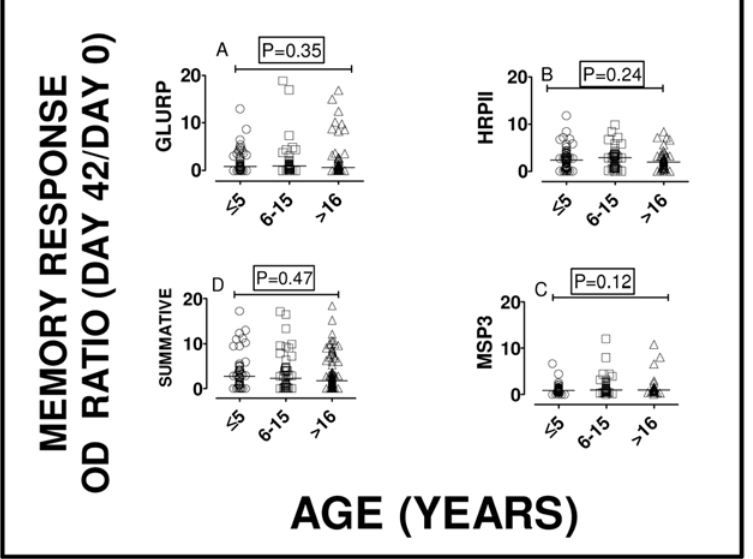
count for the HIV + individuals (n = 24) was 1210/mm 3 (IQR: 719 – 1547), while for the HIV